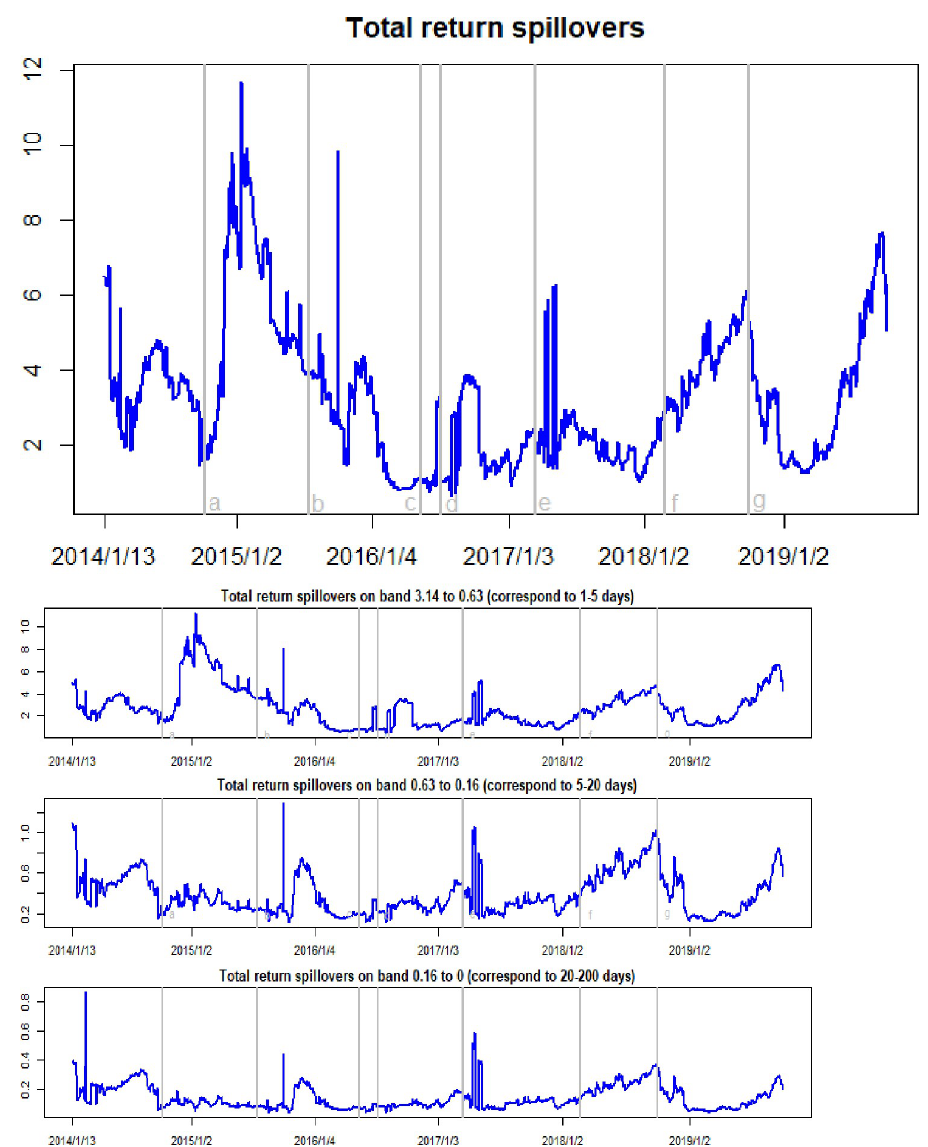
Fig 5. Time-frequency dynamics of total returns spillovers. a, b, c, d, e, f, g respectively represent the seven events: the WTI oil price collapsed in October 2014, the black swan event in gold market occurred in July 2015, the sharp rise of bitcoin prices in May 2016, the Brexit event in July 2016, the expectations of a Federal Reserve rate hike in March 2017, the price of Bitcoin and gold fluctuating fall at the beginning of 2018, and the WTI oil price declines in August